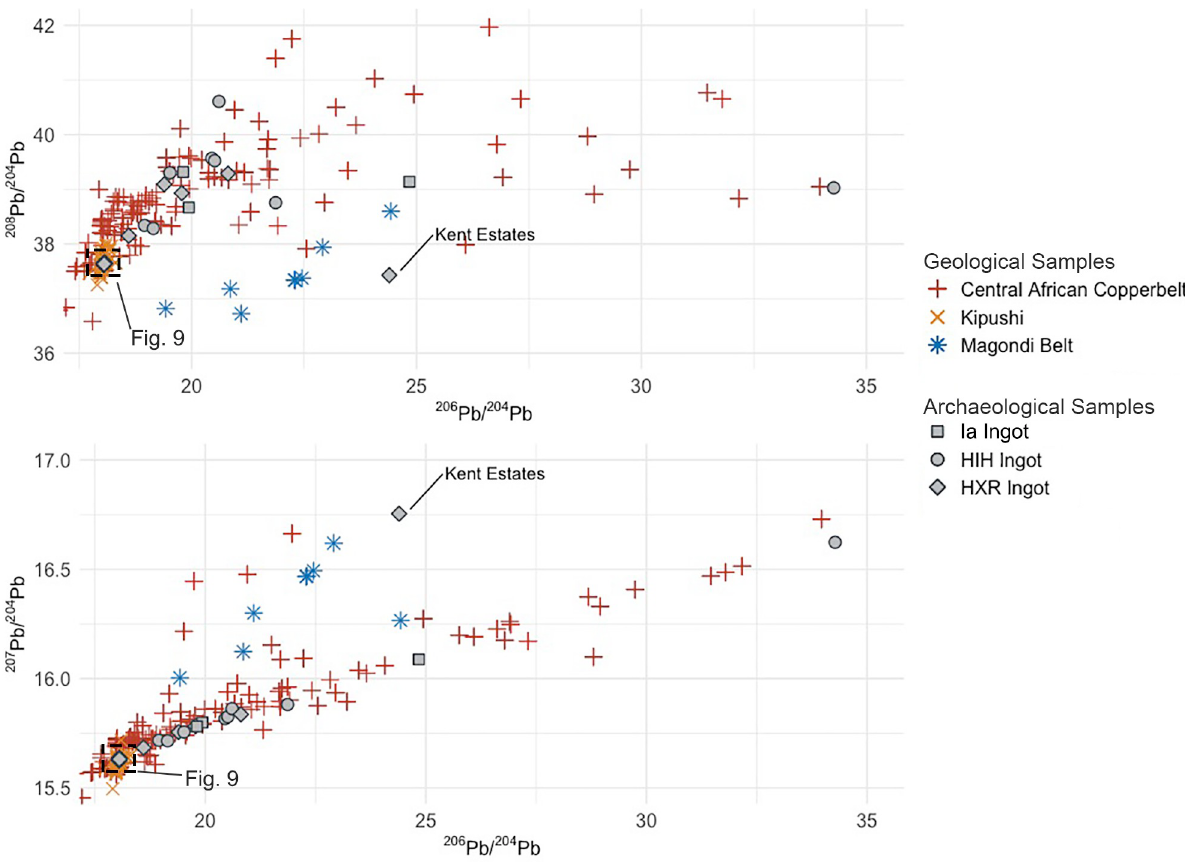
Fig 8. LIA data from croisette ingots. Comparison of HIH and HXR ingot LIA data to geological ore LIA data from the Central African Copperbelt and Magondi belt. Ore data in the S3 Appendix from compilation of Killick et al. [59] and data produced by Stephens in 2020. The Kent Estates HXR ingot clearly diverges from the dominant trend in Copperbelt LIA values and is a better match for the Magondi belt. However, more isotopic measurements of Magondi belt ore samples are needed to better define this trend line, and to investigate whether individual ore deposits within this mining district can be